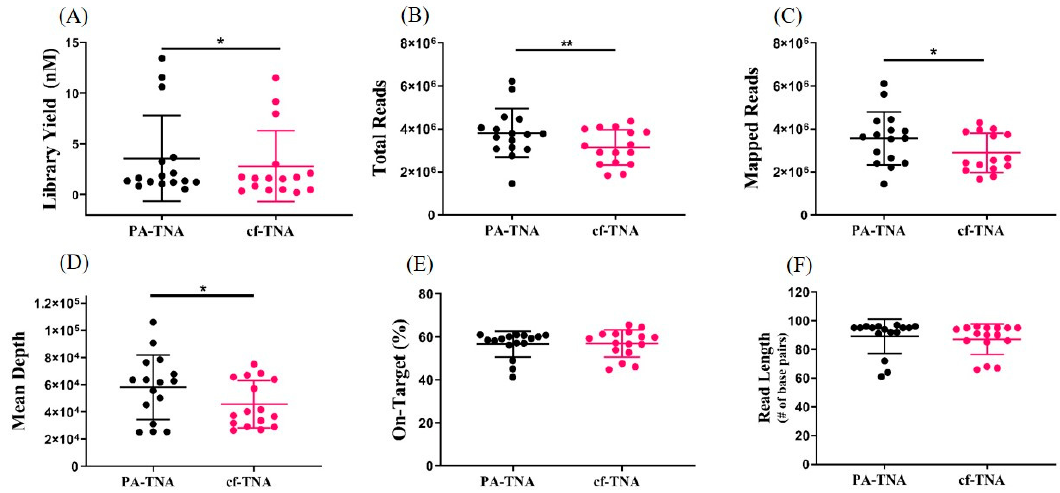
Figure 3. PA improves performance of next generation sequencing compared to cf-TNA. PA-TNA or cf-TNA extracted from EDTA plasma from NSCLC patients was sequenced by Next Generation Sequencing using an Oncomine Cell-Free Total Nucleic Acid panel. Up to 50 ng of PA-TNA or cf-TNA isolated from up to 4 mL of EDTA plasma was used to generate barcoded libraries. The libraries were quantified by Tapestation ( A ), multiplexed and amplified on an Ion Chef instrument and sequenced on an Ion Genestudio S5 sequencer. Comparisons of di ff erent NGS parameters including total reads ( B ) mapped reads ( C ) mean sequencing depth ( D ) percent of on-target reads ( E ) and mean read length ( F ) are shown. ( n = 16; * p < 0.05, ** p < 0.01).